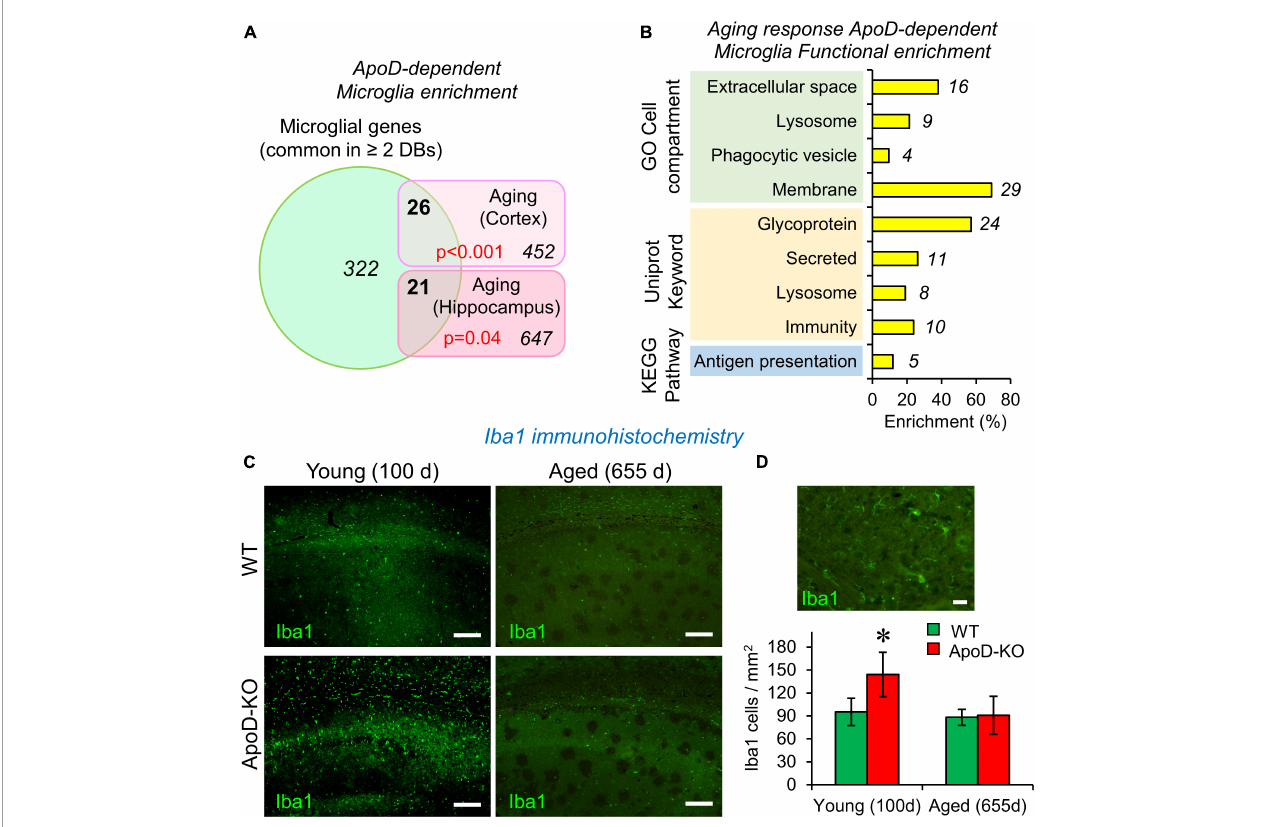
FIGURE1 The expression of Apolipoprotein D (ApoD) alters the microglial response to aging. (A,B) Bioinformatics analysis of microglia-specific gene enrichment within sets dependent on ApoD expression. Microglia-specific genes are enriched in the set of genes that depend on ApoD for their response to aging in the brain. P -values are calculated with a modified Fisher’s exact test (A) . Functional enrichment analysis of the set of genes identified in (A) , carried out with the DAVID platform (B) . (C) Young adult mice lacking ApoD expression increase their number of microglial cells in the hippocampus, a genotype-dependent response that disappears upon physiological aging. Degenerated regions in brain tissue are evident in aged samples. Representative images are shown. (D) Microglial cells labeled by Iba1 antibody and graphical quantification of Iba1-positive cells in young (100 days) (two serial sections; n = 3/genotype) and aged (655 days) (two serial sections; n = 4/genotype) samples. Asterisk points to significant differences between young and aged groups (Student’s t -test). Calibration bars: 100 µ m (C) ; 20 µ m (D)